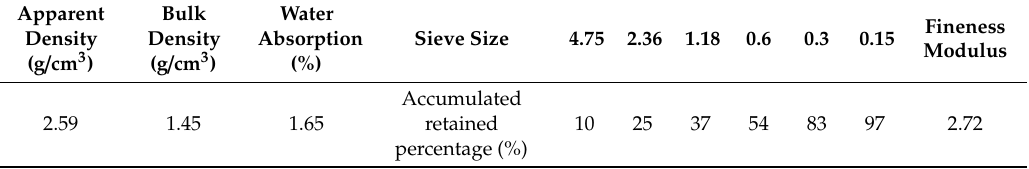
Table 1. Physical results and particle size distribution of fine aggregate (natural river sand).